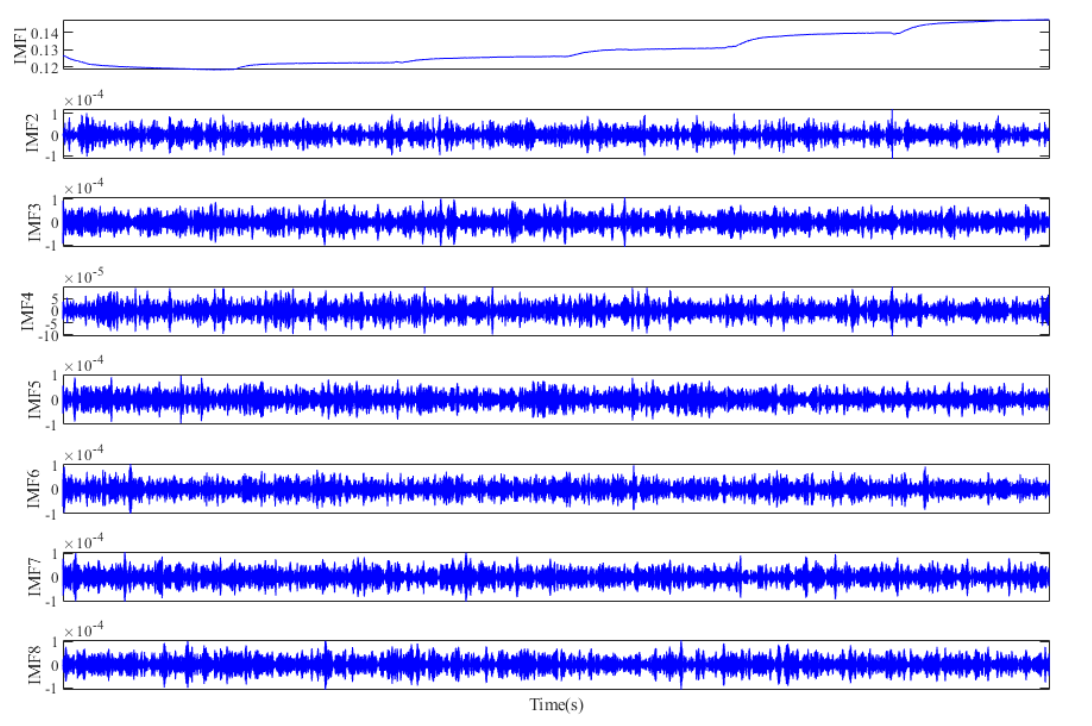
Figure 12. The decomposition of gyroscope output by MOVMD.